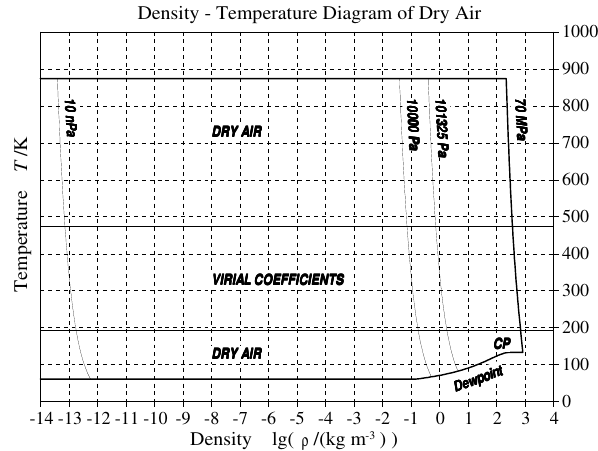
Fig. 4 Validity range of the Helmholtz function for humid air, Eq. (2.7). For Fig. 4. Validity range of the Helmholtz function for humid air, oceanographic and meteorological applications it is unnecessary to consider liquid or Eq. (2.7). For oceanographic and meteorological applications it is solid air. Thus, we restrict consideration of Eq. (4.37) as follows: i) for temperatures above the critical temperature of dry air, T > T c = 132.5306 K, all density values unnecessary to consider liquid or solid air. Thus, we restrict consid- occurring between the pressure bounds are permitted; and ii) for subcritical eration of Eq. (4.37) as follows: (i) for temperatures above the crit- temperatures T < T c , only densities below the dewpoint curve of dry air, indicated by “Dewpoint” are permitted. The resulting validity boundary for dry air is shown in ical temperature of dry air, T >T c =132.5306K, all density values bold. “CP” is the critical point of dry air. To consider humid air, virial coefficients are occurring between the pressure bounds are permitted; and (ii) for required. The validity range in temperature of the third virial coefficients is shown by horizontal lines. Additionally, the pressure on saturated humid air is restricted to 5 subcritical temperatures T <T c , only densities below the dewpoint MPa (Hyland and Wexler 1983), not shown. curve of dry air, indicated by “Dewpoint” are permitted. The re- sulting validity boundary for dry air is shown in bold. “CP” is the The air fraction is bound between 0 and 1 but is additionally limited by the vapour saturation critical point of dry air. To consider humid air, virial coefficients condition, Fig. 5 . At high total pressures, the restriction to vapour pressures below the saturation value represents a significant limitation on the upper limit of 1 – A that can be are required. The validity range in temperature of the third virial achieved in thermodynamic equilibrium. For total pressures below the vapour pressure of coefficients is shown by horizontal lines. Additionally, the pressure liquid water or the sublimation pressure of ice at the given temperature, the value of A may take any value between 0 and 1. on saturated humid air is restricted to 5MPa (Hyland and Wexler 1983), not shown.